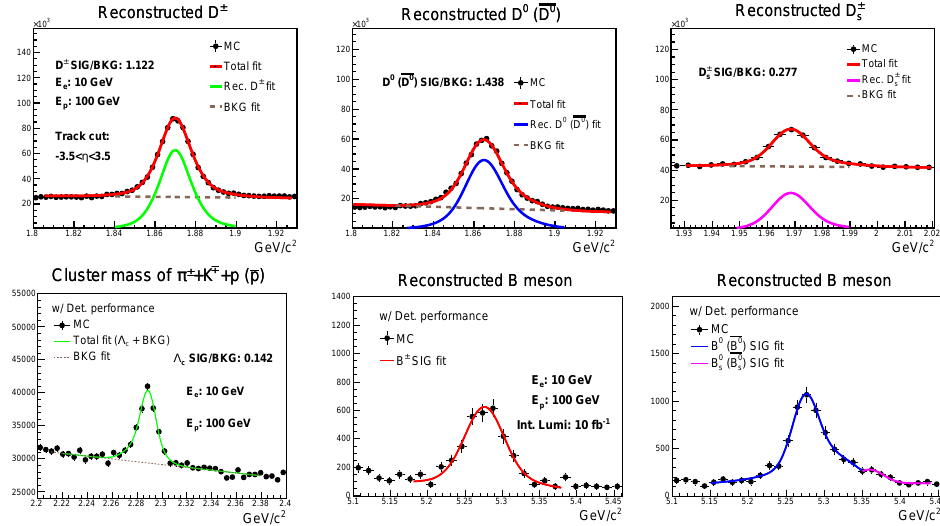
Figure 2: Reconstructed heavy flavor hadron mass spectrums with the evaluated silicon tracking detector performance using the Babar magnet (shown in the top row of Figure 1)) in 63.2 GeV e + p collisions with integrated luminosity of 10 f b − 1 . Jets are reconstructed via the anti- k algorithm [ 7 ] with the cone T